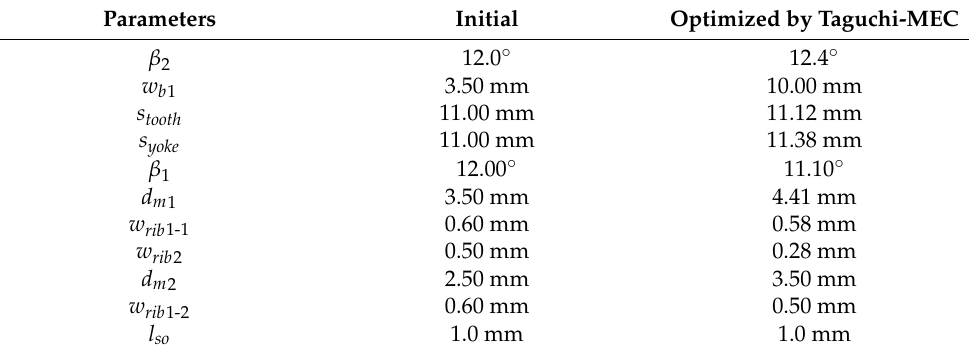
Table 5. Comparison of the Parameters and Performances.